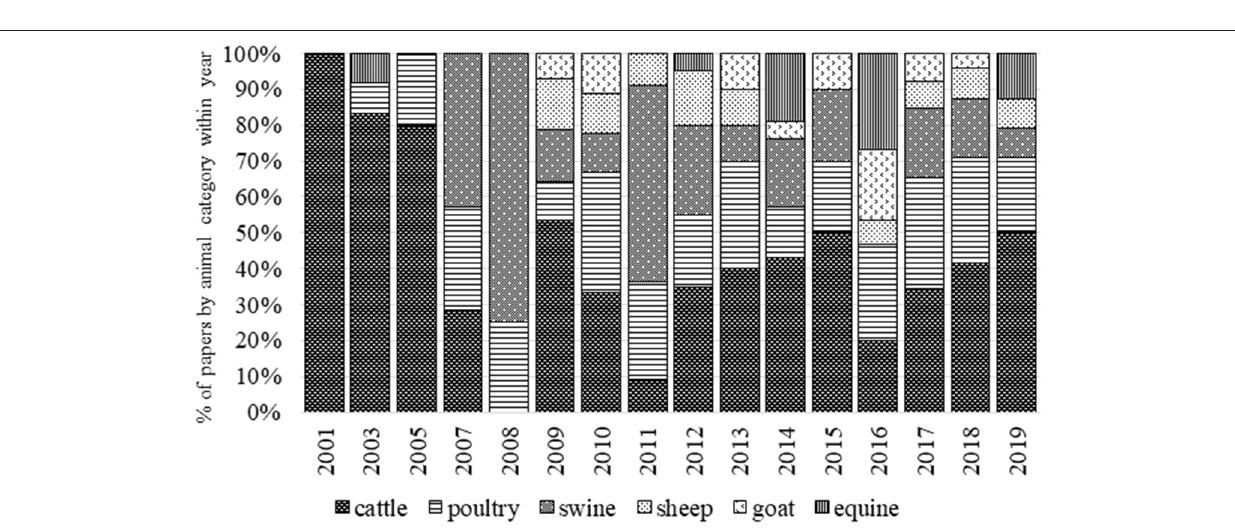
FIGURE 3 | Percentage of papers including a general animal-based measures codified term according to the animal species.